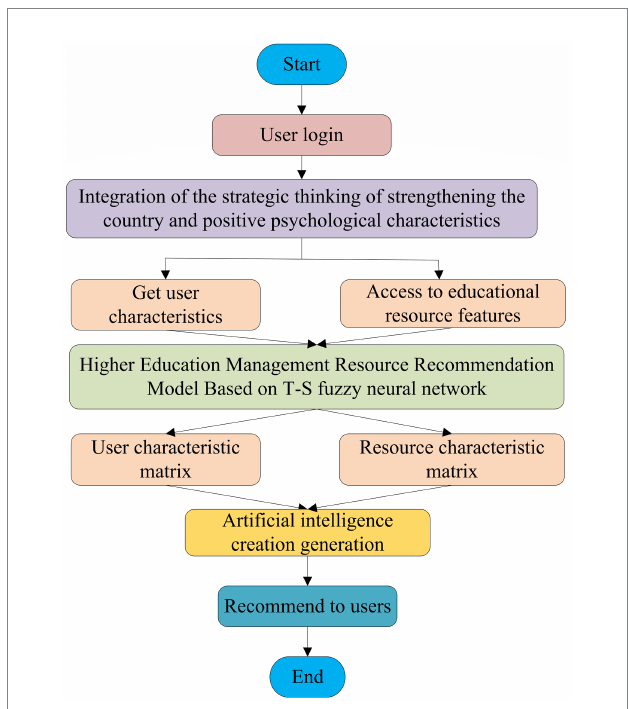
FIGURE 5 T–S fuzzy neural network educational resource recommendation model